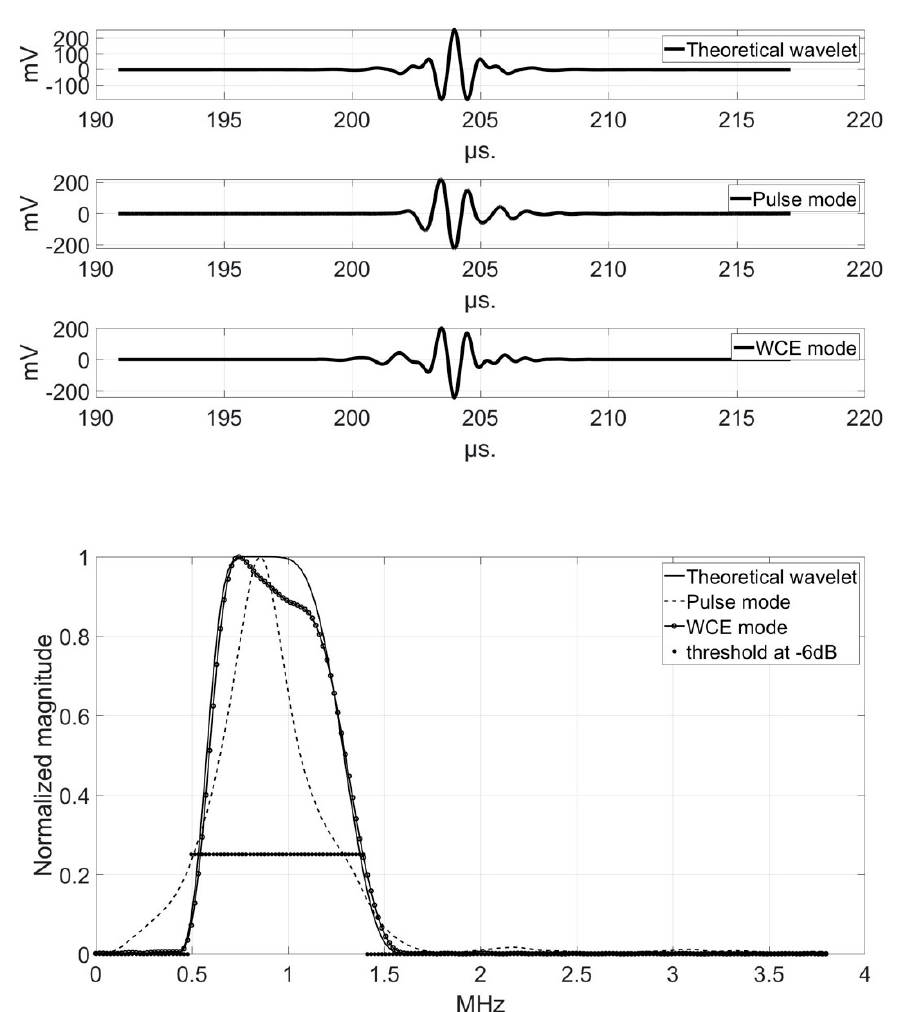
Figure 7. Comparison of the temporal representations ( top ) and frequency spectra ( bottom ) of the theoretical analyzing wavelet (solid line), the transmitted pulse signal (dashed line), and the pseudo-wavelet (dotted line) for the 1 MHz-transducer.